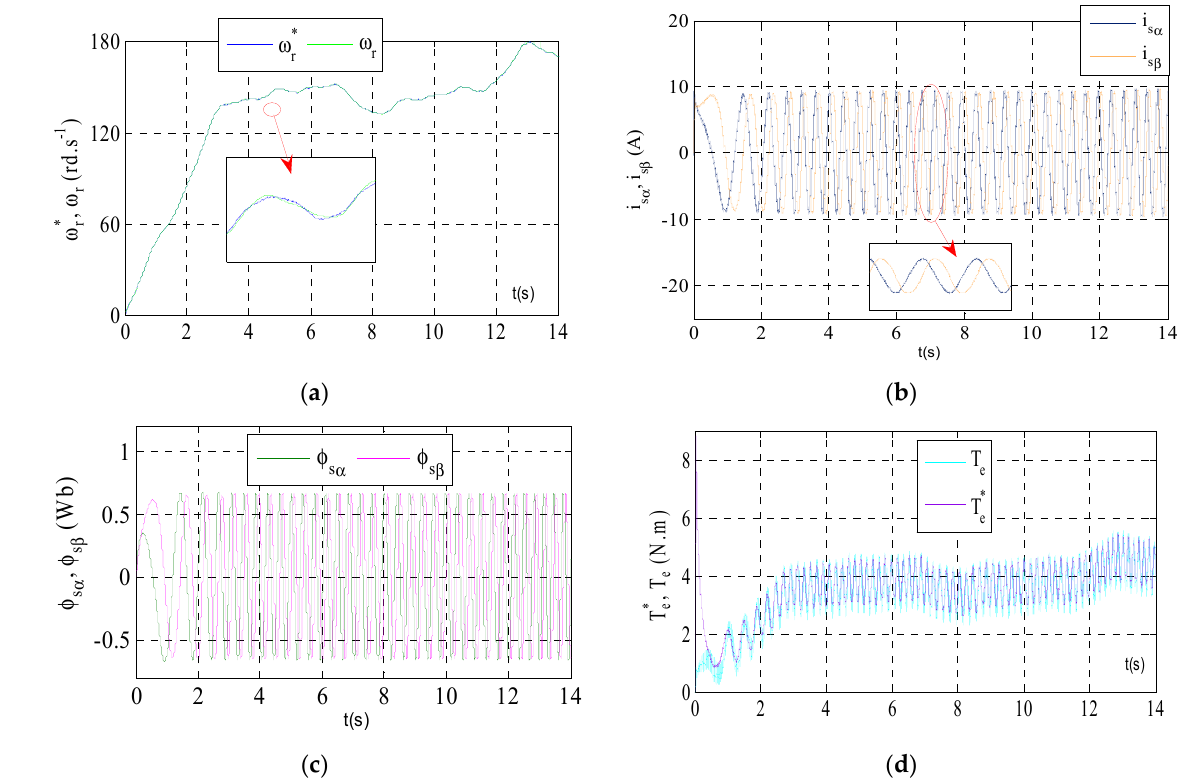
Figure 16. Digital Simulation results of IRFOC TPIM drive fed by an advanced SVM controlled 2 ϕ - inverter under sinusoidal wind speed profile by introducing a load torque variation: ( a ) turbine and TPIM speeds; ( b ) TPIM stator currents; ( c ) TPIM stator fluxes and ( d ) TPIM electromagnetic torques.